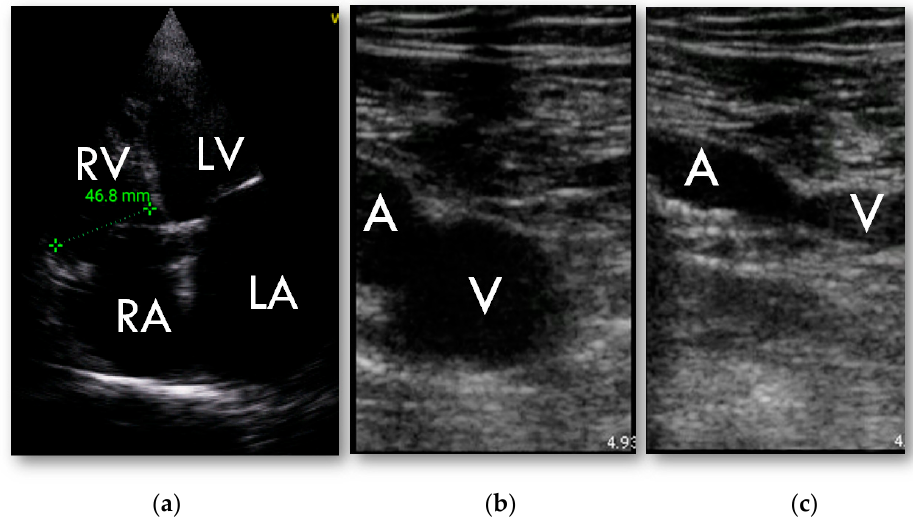
Figure 4. HUD examination; ( a )—RV focused 4-chamber apical view, basal dimension; ( b , c )—compression ultrasound test of common femoral vein: ( b )—without compression; ( c )—abnormal examination in deep vein thrombosis. Vein is not entirely occluded.